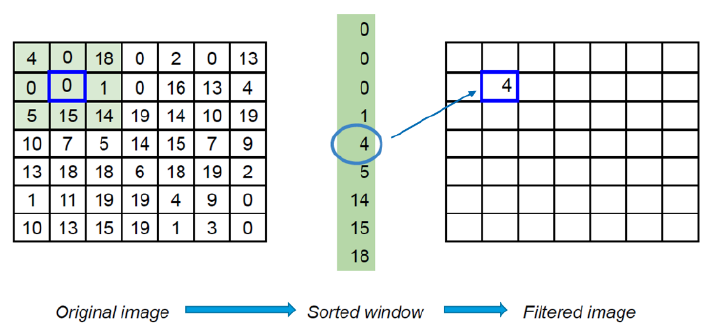
Figure 5. Example of how the median filter works.